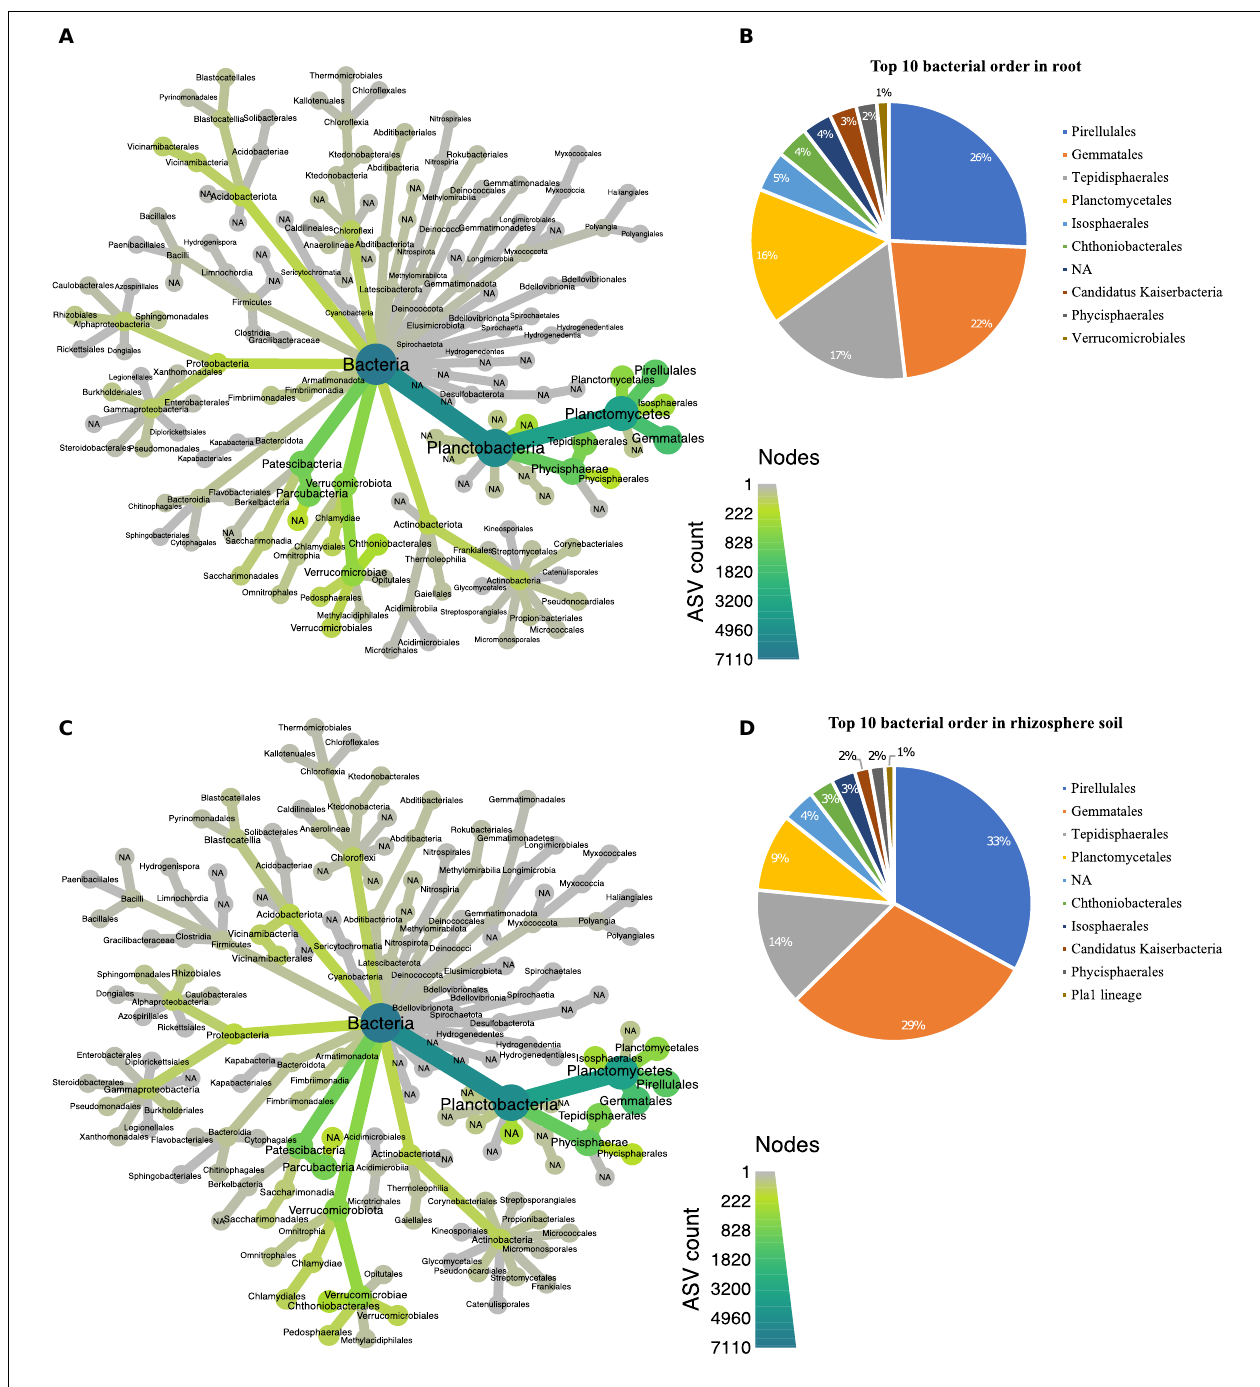
FIGURE 4 | Taxonomic hierarchy abundance at the order level for bacterial communities. (A) Taxonomic representation at order level in root; (B) relative abundance of top 10 bacterial orders in root. (C) Taxonomic representation at order level in rhizosphere soil (D) relative abundance of top 10 bacterial orders in rhizosphere soil. Three replicates were used for this